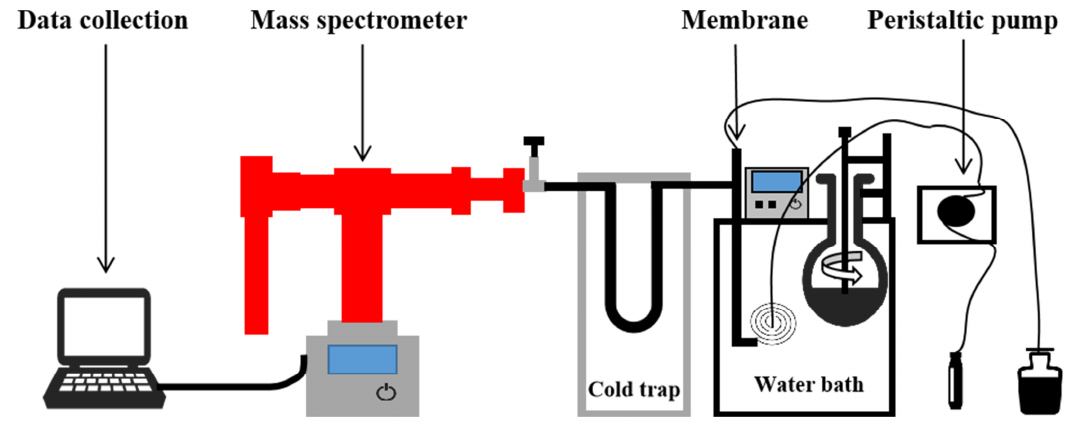
Figure 1. The diagram of the MIMS system.